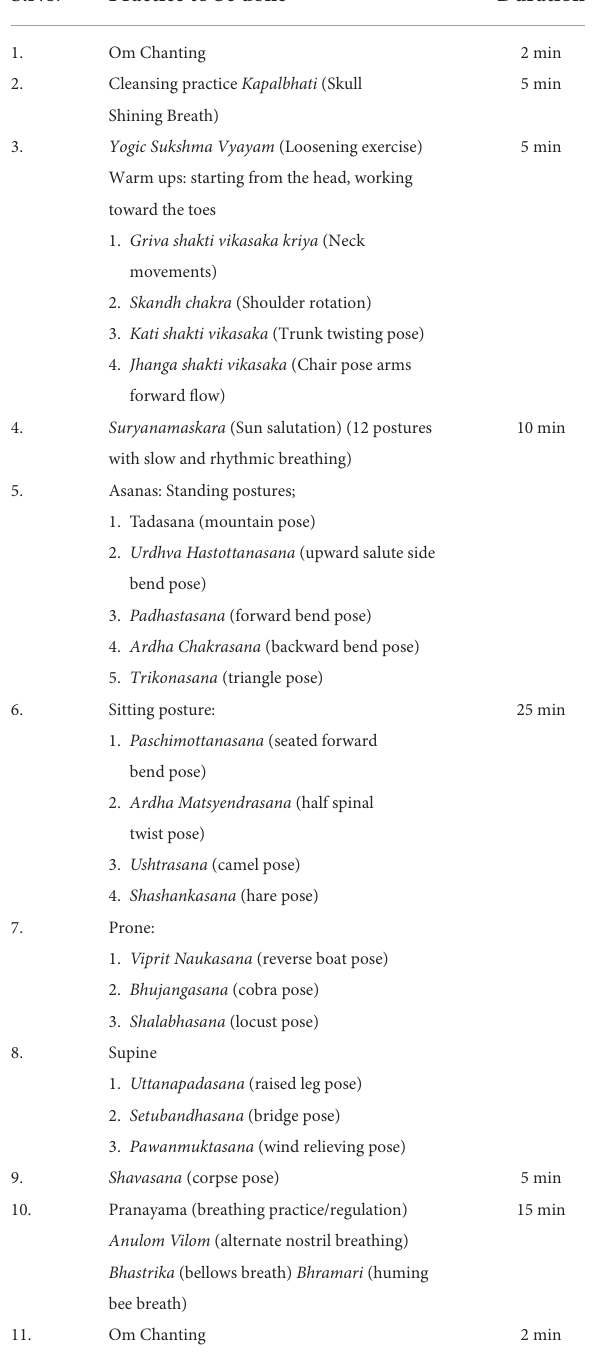
TABLE 2 Details of activities performed in a single session of the Yoga-Based Lifestyle Intervention. S.No